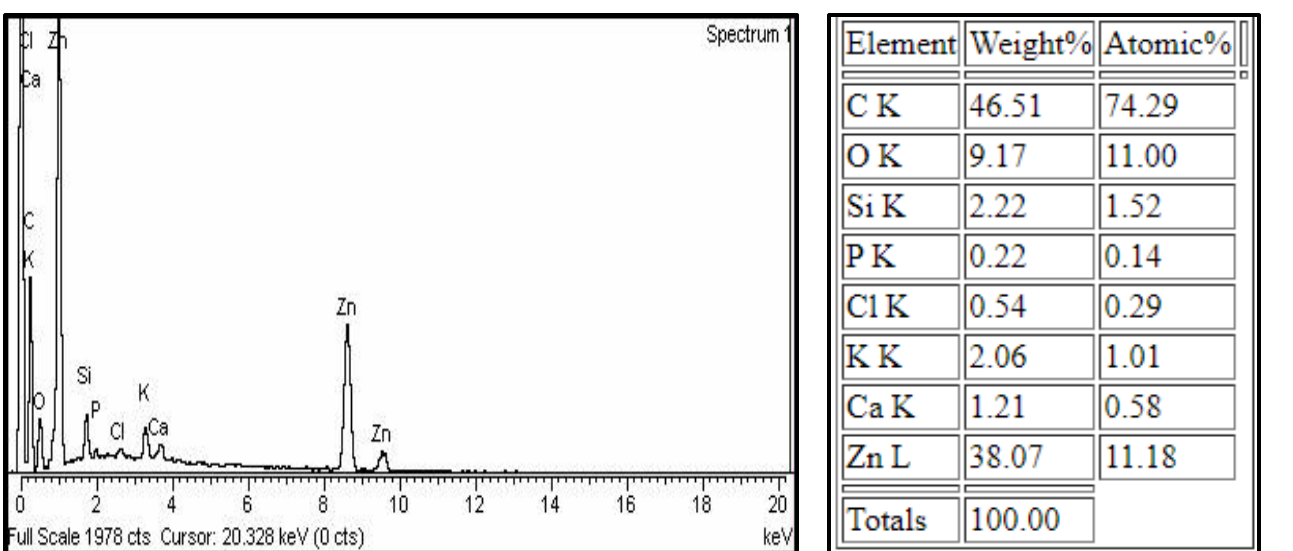
Figure 5. SEM micrographs of pristine MB ( A ) and MB-ZnO ( B ).